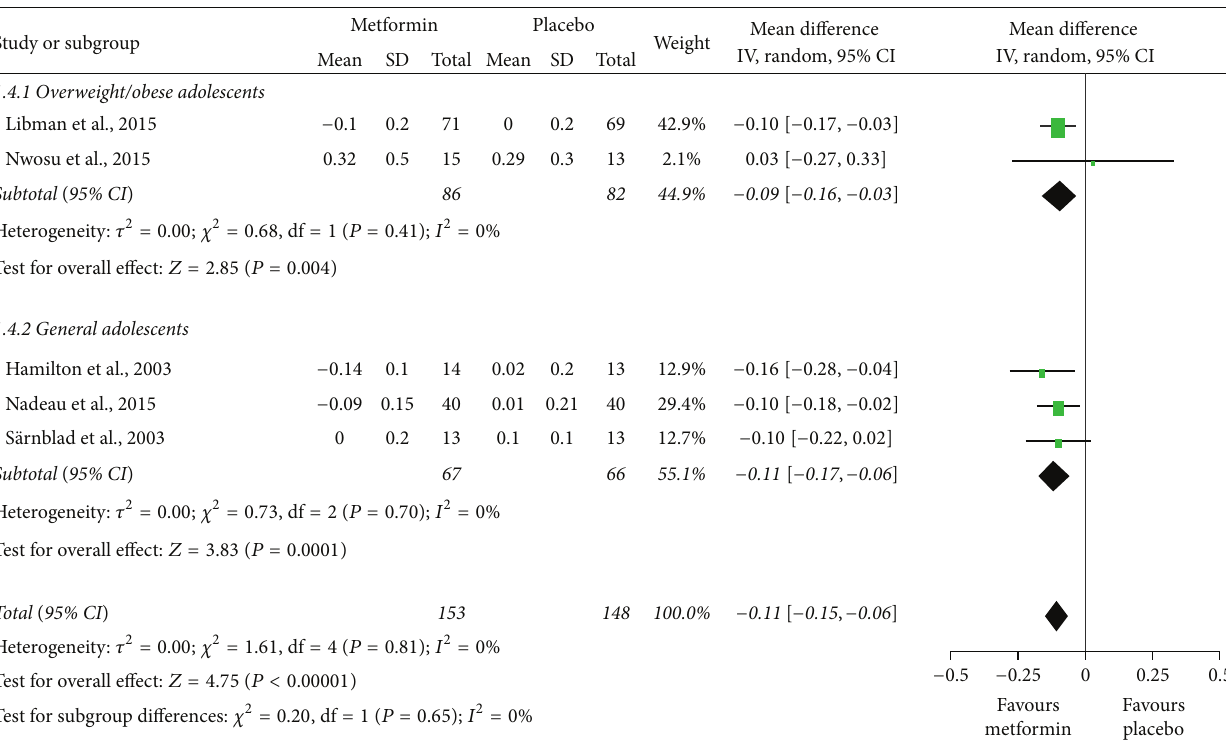
adolescents with T1DM by 1.77-fold (RR = 1.77 , 95% CI: